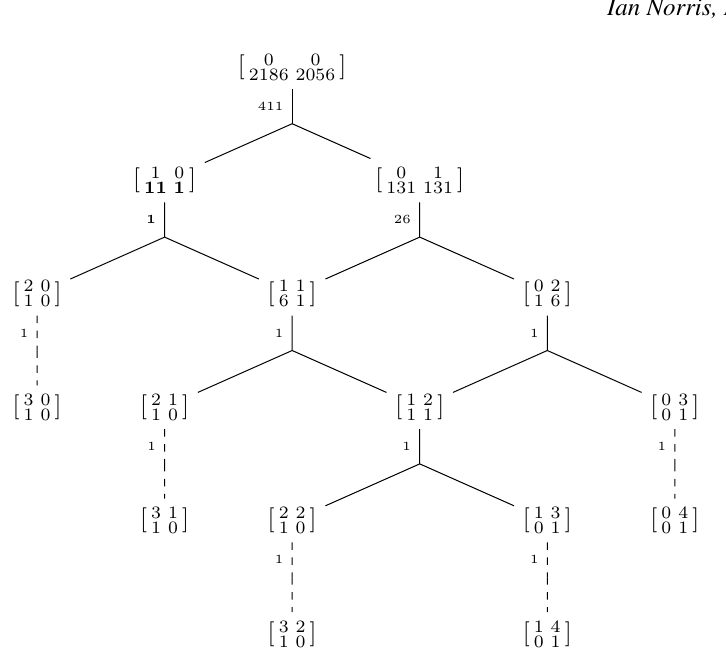
Figure 3: A stage diagram for b 1 = 1 , b 2 = 2 , l 1 = 3 and l 2 = 4